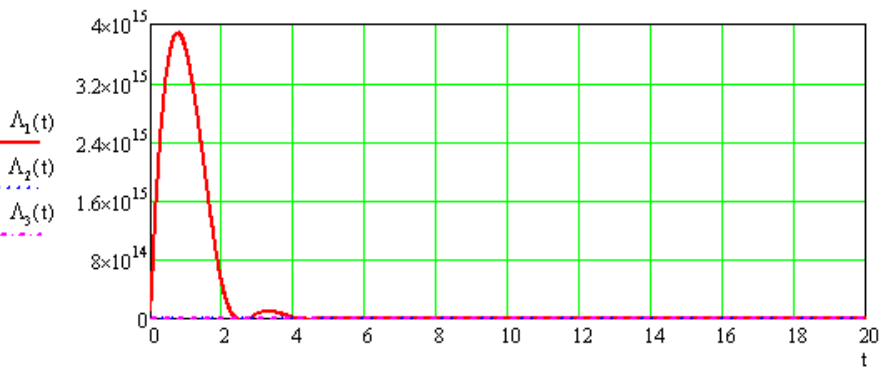
—program functions for the first, second, and third objects, respec- tively.